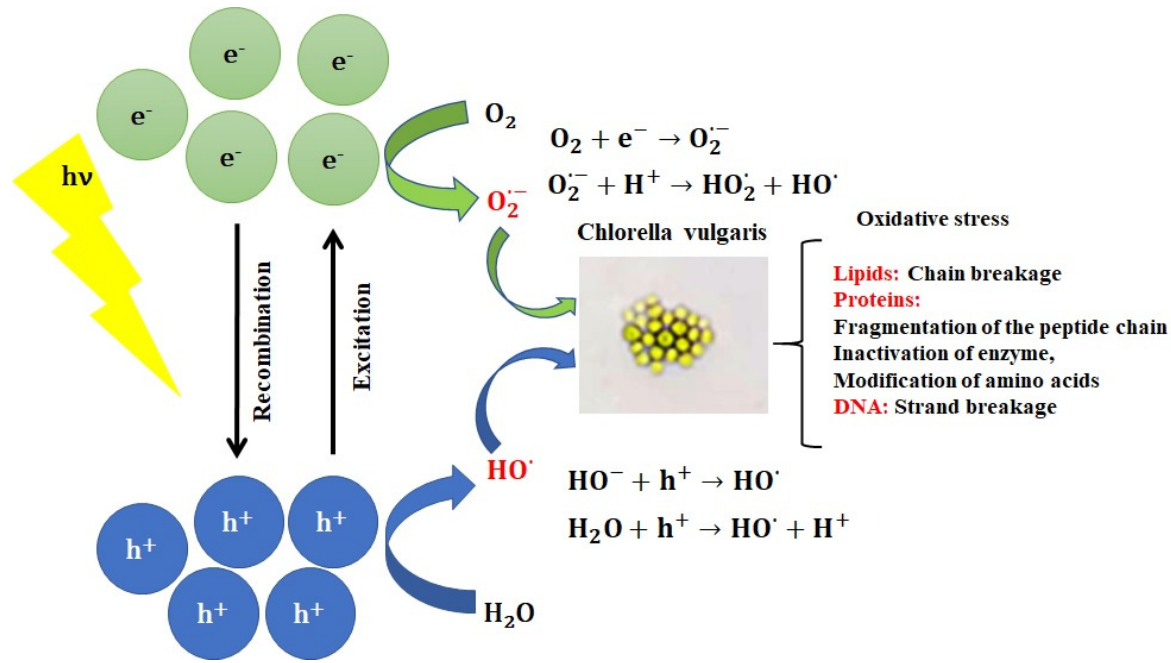
Figure 1. Reactive oxygen species produced during photocatalysis induce oxidative damage to algae cells.